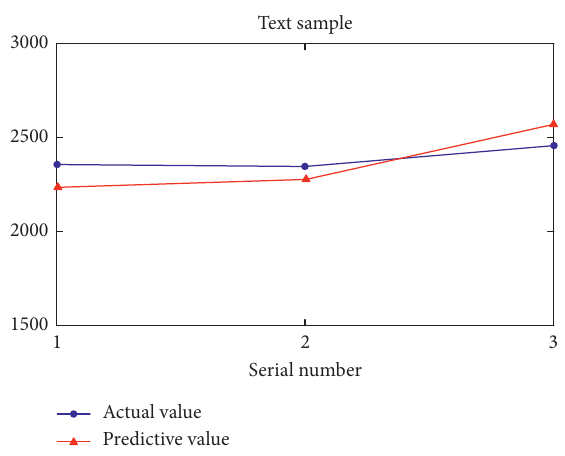
Figure 12: PSO-BP network test sample.